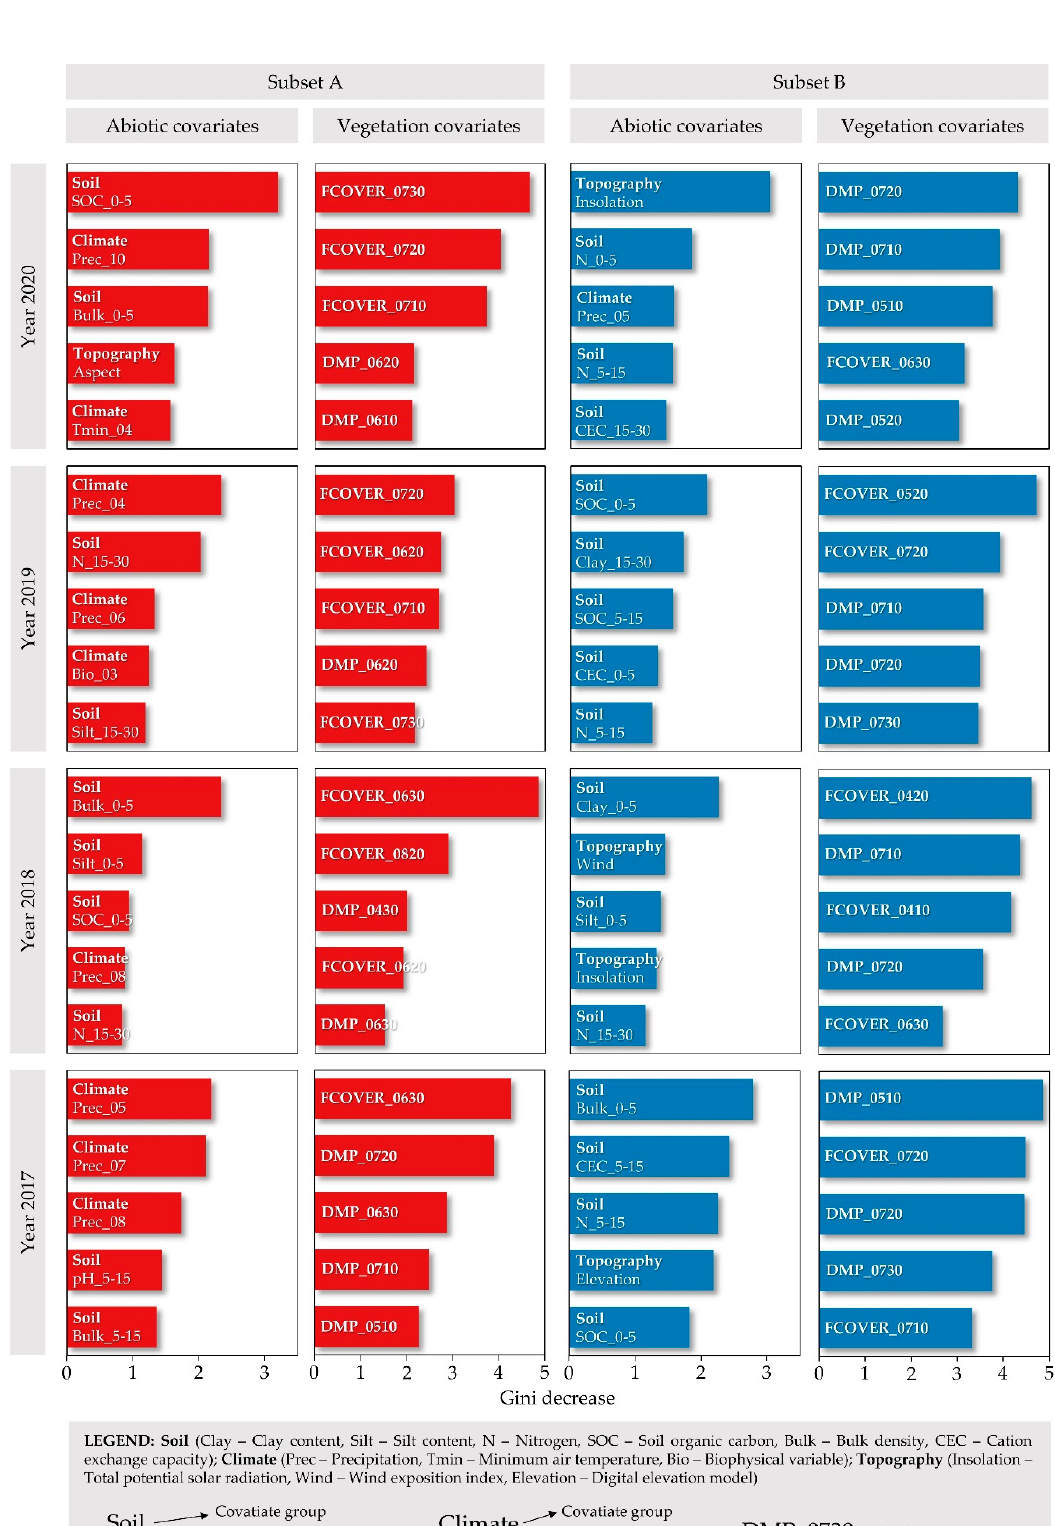
Figure 7. Relative importance of top five (out of 119) abiotic and vegetation covariates using Gini decrease values per yearly cropland suitability result.